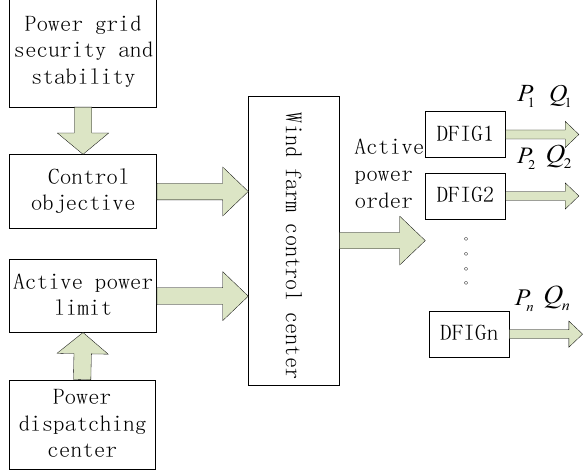
Fig.1. Wind farm control structure